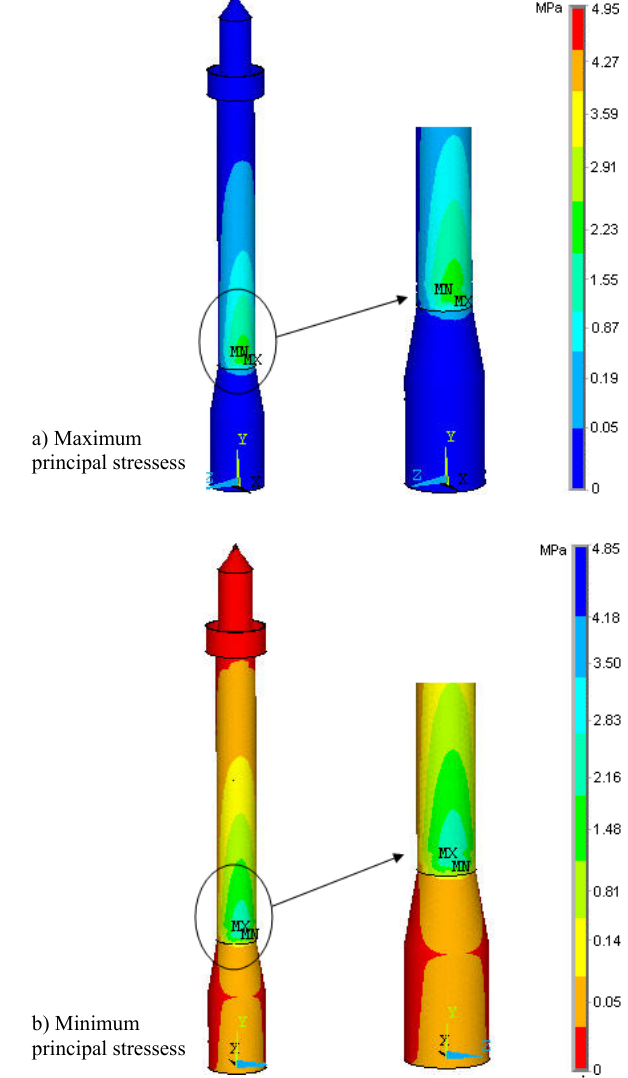
lation, FRP composite strengthening should be consid- ered and the responses should be compared before the FRP composite